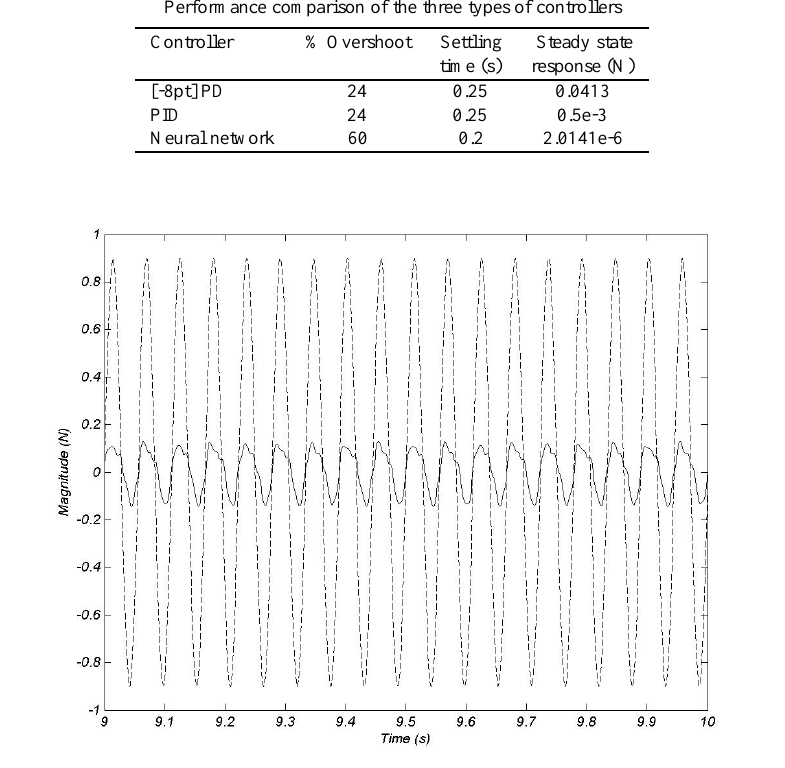
Fig. 28. Transmitted force variations of the system using the PD controller subjected to periodic engine disturbance at idling frequency at the final 1 seconds of the simulation. Open loop (–) and NN controlled (solid). It can be observed from Figs 29 and 30 the magnitude of the steady state response of the neural network controlled system is much lower by approximately 60%. Thus, the NARMA-L2 neural controller shows a better performance than the PD and PID tuned using the Ziegler-Nichols tuning